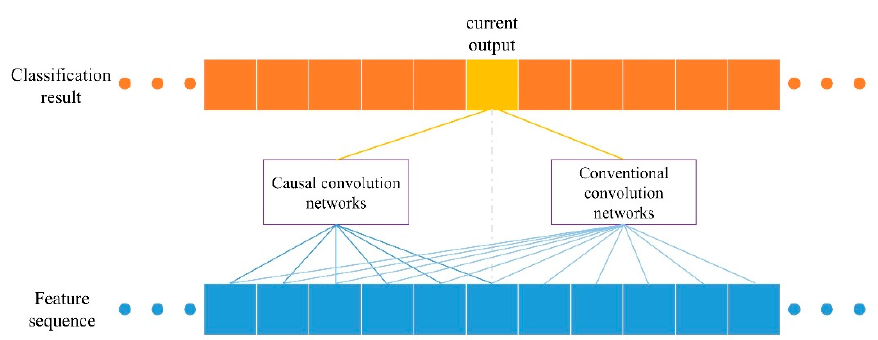
Figure 4. Simplified visualization of causal convolution and conventional